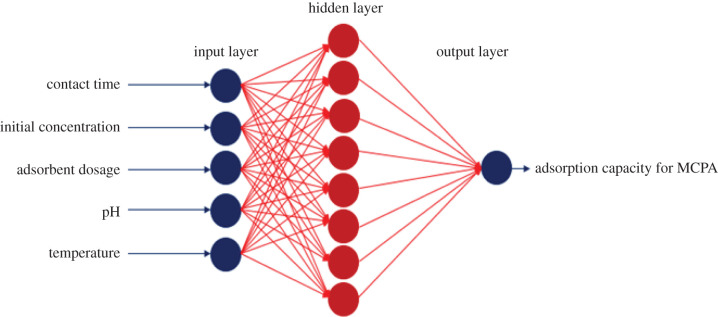
Artificial neural network topology.